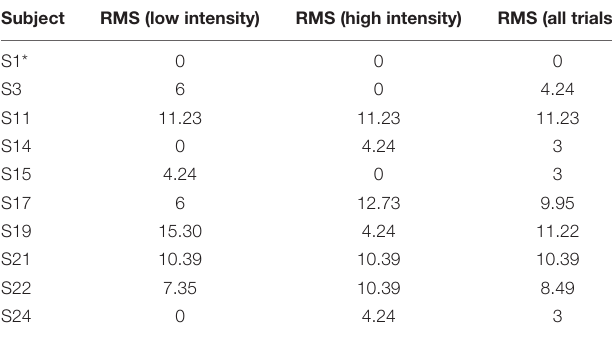
TABLE 2 | RMS results of low intensity, high intensity, and all trials.